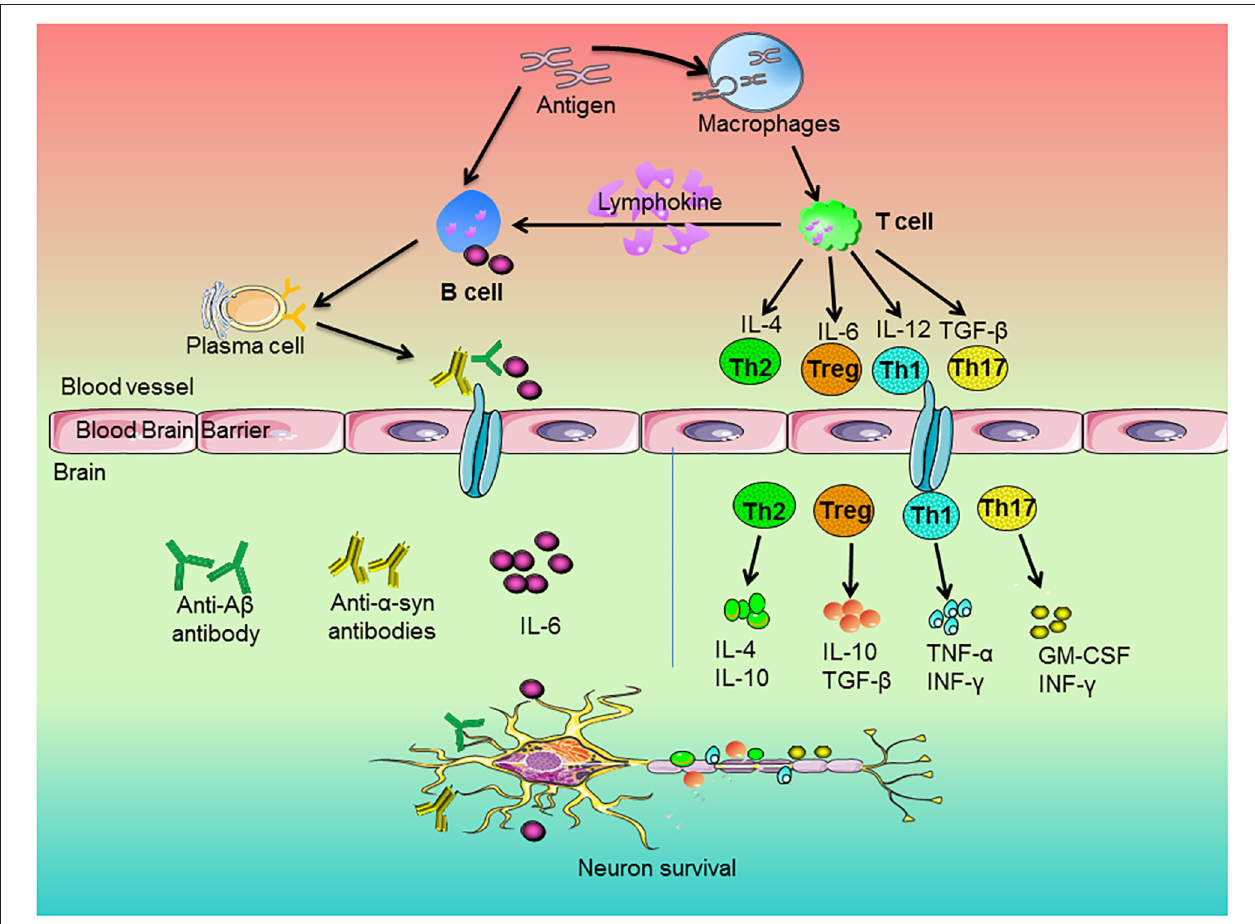
FIGURE 1 | Roles of peripheral immune cells on the pathogenesis of neurodegenerative diseases. The antigen stimulated the immune response of macrophages and B cells. Macrophages engulfed antigens and presented them to T cells. The cytokines of IL-4, IL-6, IL-12, and TGF- β released by T cells regulated the development of Th2, Treg, Th1, and Th17 cells, respectively. Then, these cells secreted anti-inflammatory or pro-inflammatory factors to regulate neuronal survival. In addition, antigens could directly stimulate B cells. Upon activation, B cells produced pro-inflammatory factors, which entered the brain along blood vessels and participated in neurodegeneration. On the other hand, activated T cells secreted lymphokines to activate B cells and activated B cells could proliferate and differentiate into plasma cells. Subsequently, the plasma cells-produced cytokines and antibodies, such as anti-A β or anti- α -synuclein antibodies, went across blood brain barrier and entered the brain and thus attenuated neurons